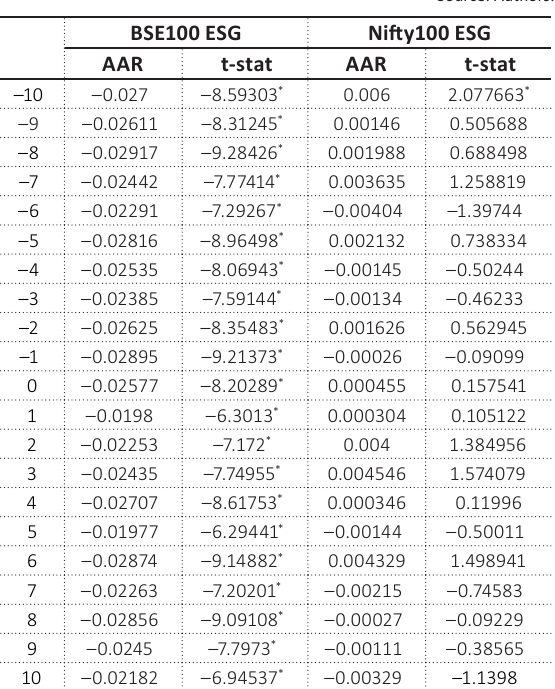
Table 4. Average abnormal return (AAR)